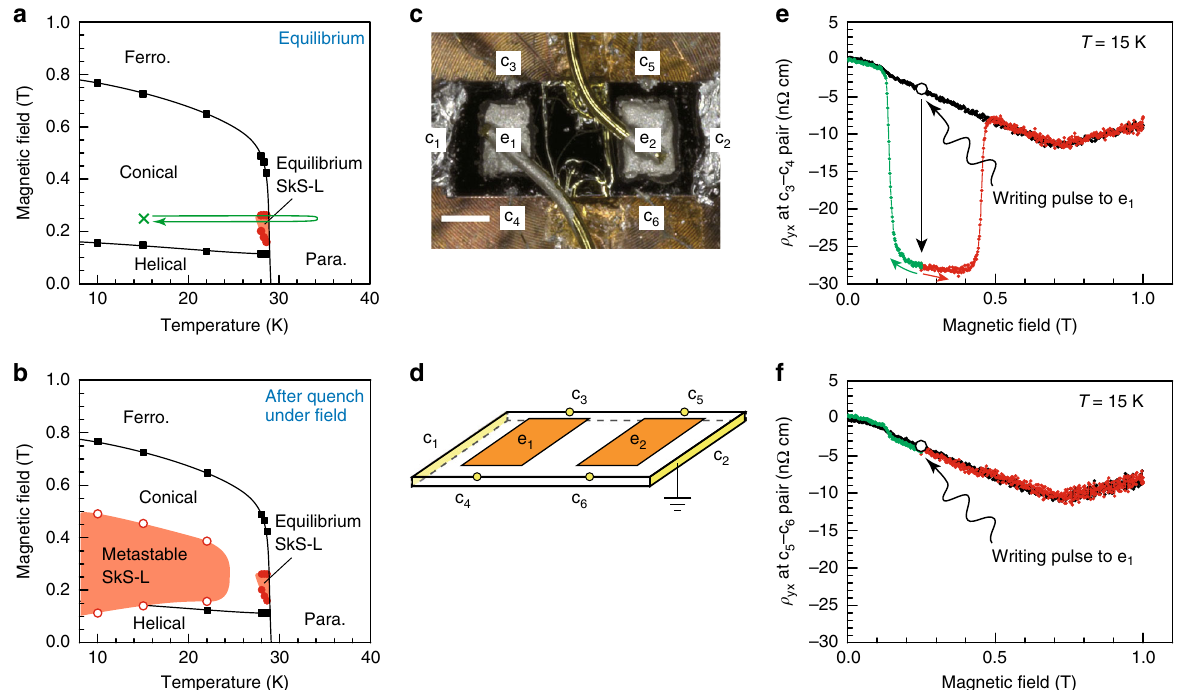
Fig. 2 Area-selective writing of the metastable SkS-L in MnSi. a , b Magnetic state diagrams of MnSi used in this study under equilibrium ( a ) and quenched conditions ( b ). Thermal quenching was performed by applying the writing pulse to the e 1 – c 2 pair (see c , d ) at 0.249 T; the thermal history that follows the pulse application is schematically shown with the arrow in a . The overall features of the phase diagram were reconstructed by referring to the literature 8, 34 , and the magnetic-phase boundaries in the present sample were determined by using a previously reported procedure 34 . c , d Photograph ( c ) and schematic diagram ( d ) of the sample con fi guration. The scale bar is 500 μ m. e , f The magnetic- fi eld dependence of ρ yx at 15 K, simultaneously measured at the c 3 – c 4 pair ( e ) and the c 5 – c 6 pair ( f ). Black curves are the data measured before application of the writing pulse (110 mA and 25 ms) to the electrode e 1 , whereas the red and green ones are those after. The effects of demagnetizing fi elds are not